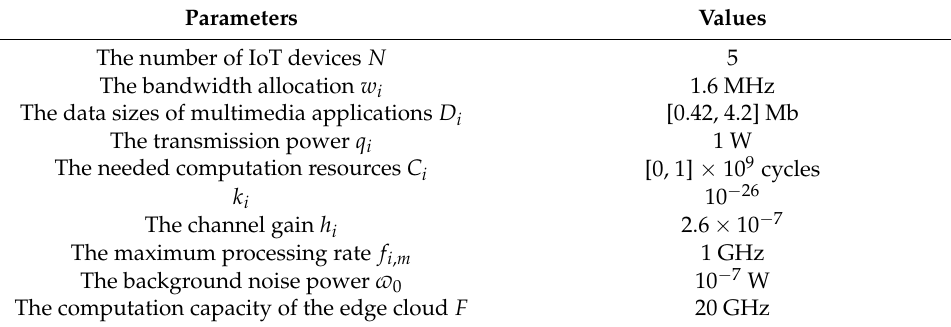
Table 3. Simulation parameter